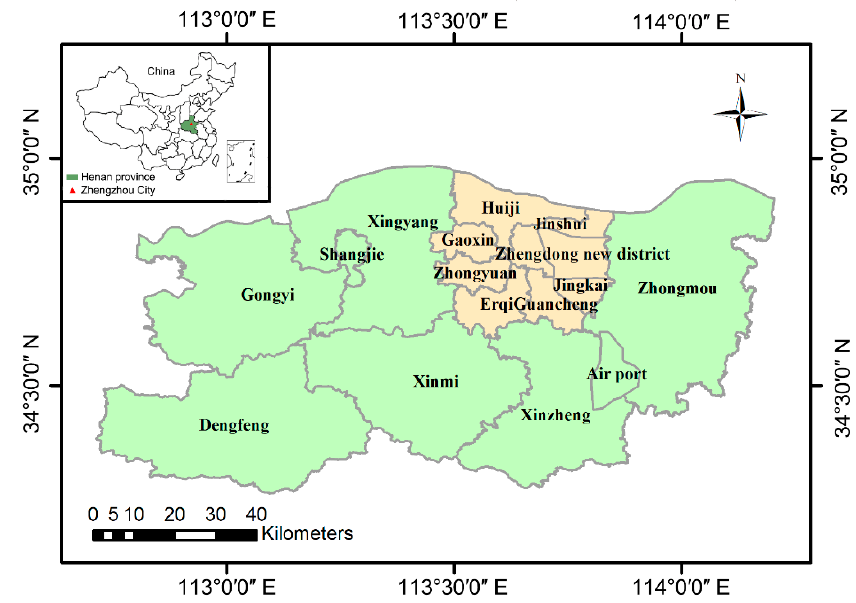
Figure 1. Geographic location and administrative district of Zhengzhou city.